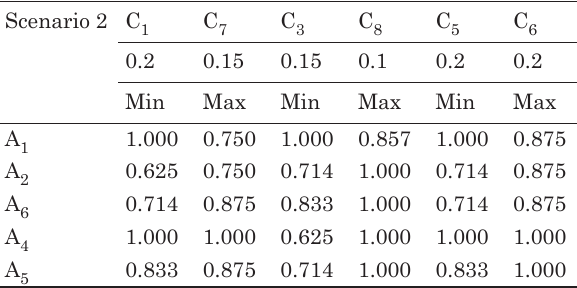
Table 5. normalized decision-making matrix for the second scenario